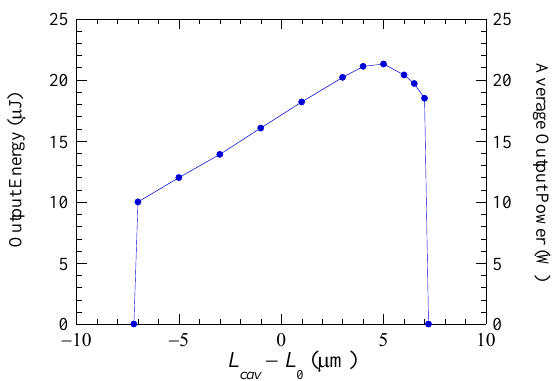
Figure 24. Output energy as a function of the cavity detuning ∆ L cav = L cav − L 0 for a hole radius of 135 µm. The simulation parameters are as described in the